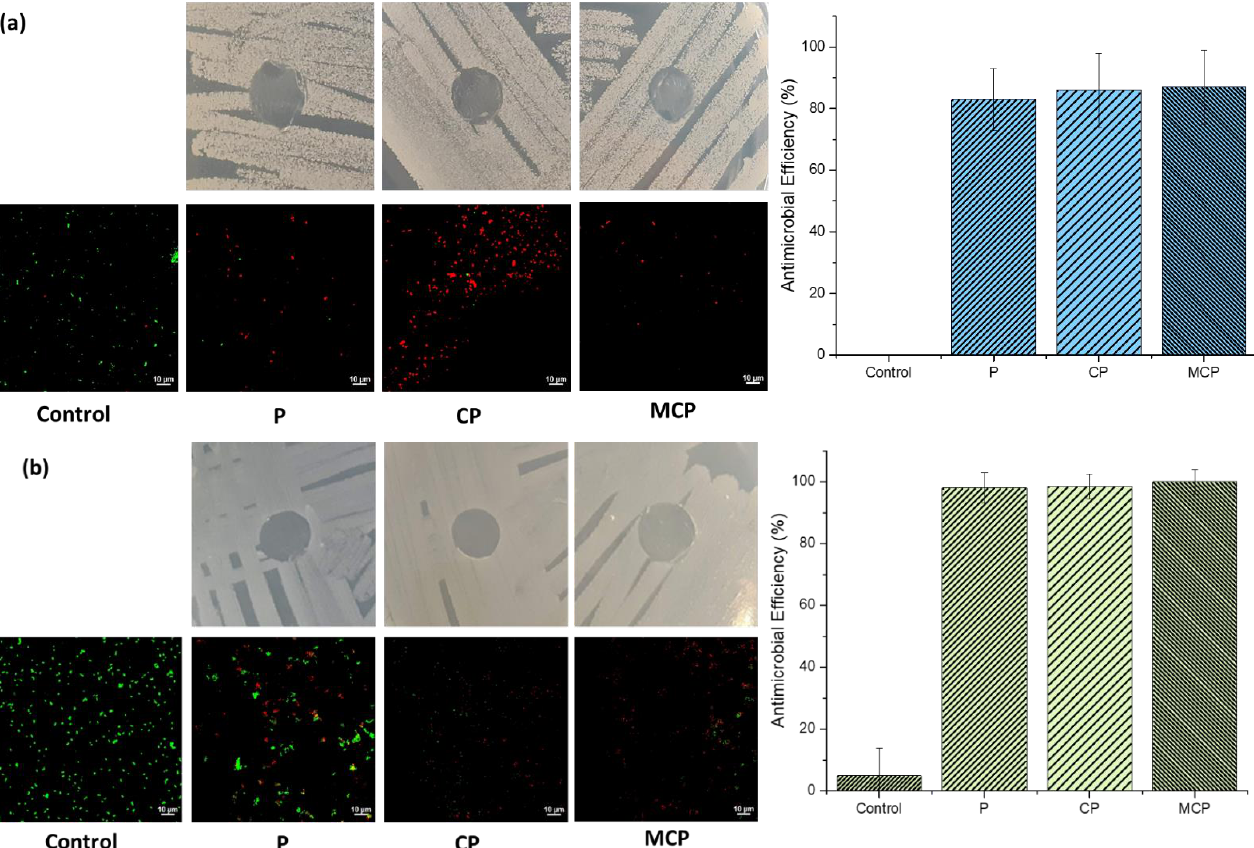
Figure 8. Antibacterial activity of P, CP, and MCP membranes for ( a ) MRSA and ( b ) E. coli .